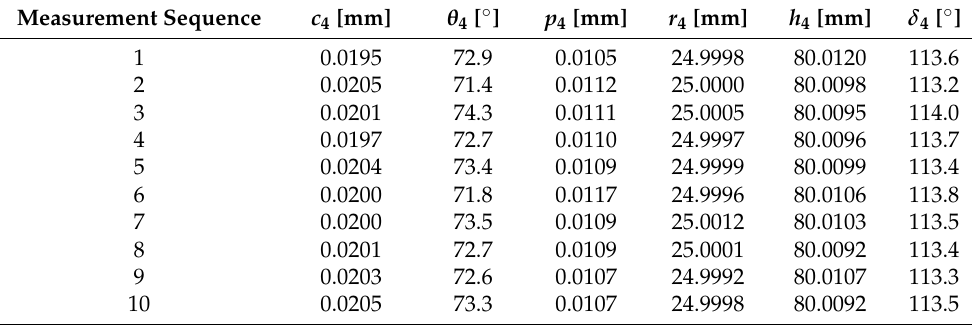
Table A4. The measured geometric parameters of the rear axle.